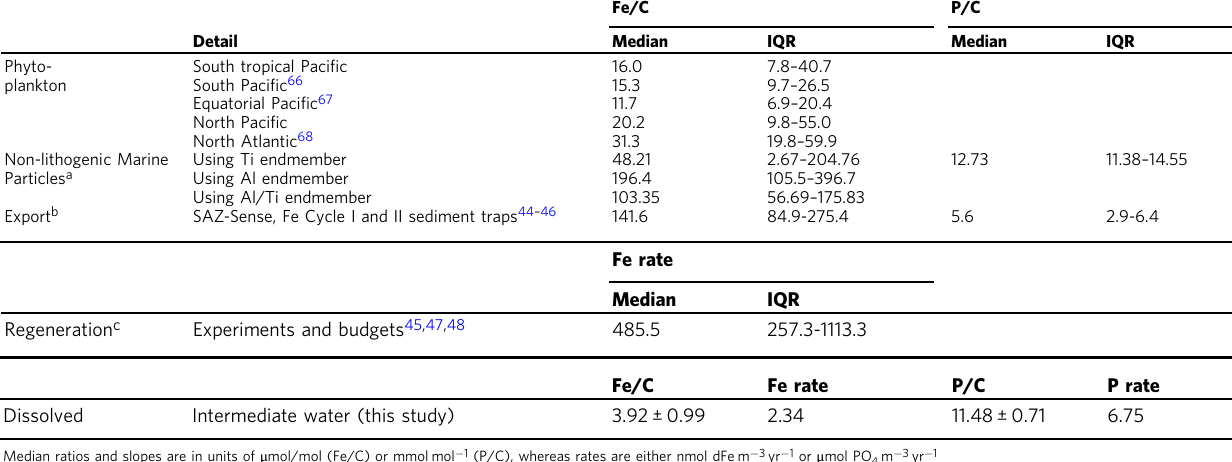
Median ratios and slopes are in units of μ mol/mol (Fe/C) or mmolmol − 1 (P/C), whereas rates are either nmol dFem − 3 yr − 1 or μ mol PO 4 m − 3 yr − 1 a Particles collected from bottles during GEOTRACES GP16 voyage between Ecuador and Tahiti in the south Paci fi c above the intermediate water layer and west of station 23 to avoid in fl uence of low- oxygen waters ( n = 54) with three different lithogenic end members applied to remove lithogenic particulate Fe. Note P/C ratio results are unaffected by the choice of lithogenic end member b Calculated non-lithogenic fl ux from sediment traps from the SAZ-Sense, Fe Cycle I and Fe Cycle II process studies, either by using local lithogenic corrections or a conservative estimate of 80% lithogenic Fe ( n = 14 for Fe and 11 for P) c Regeneration rates are compiled from all direct measurements of solubilisation of particles collected from below the mixed layer and iron budget calculations of iron regeneration ( n =